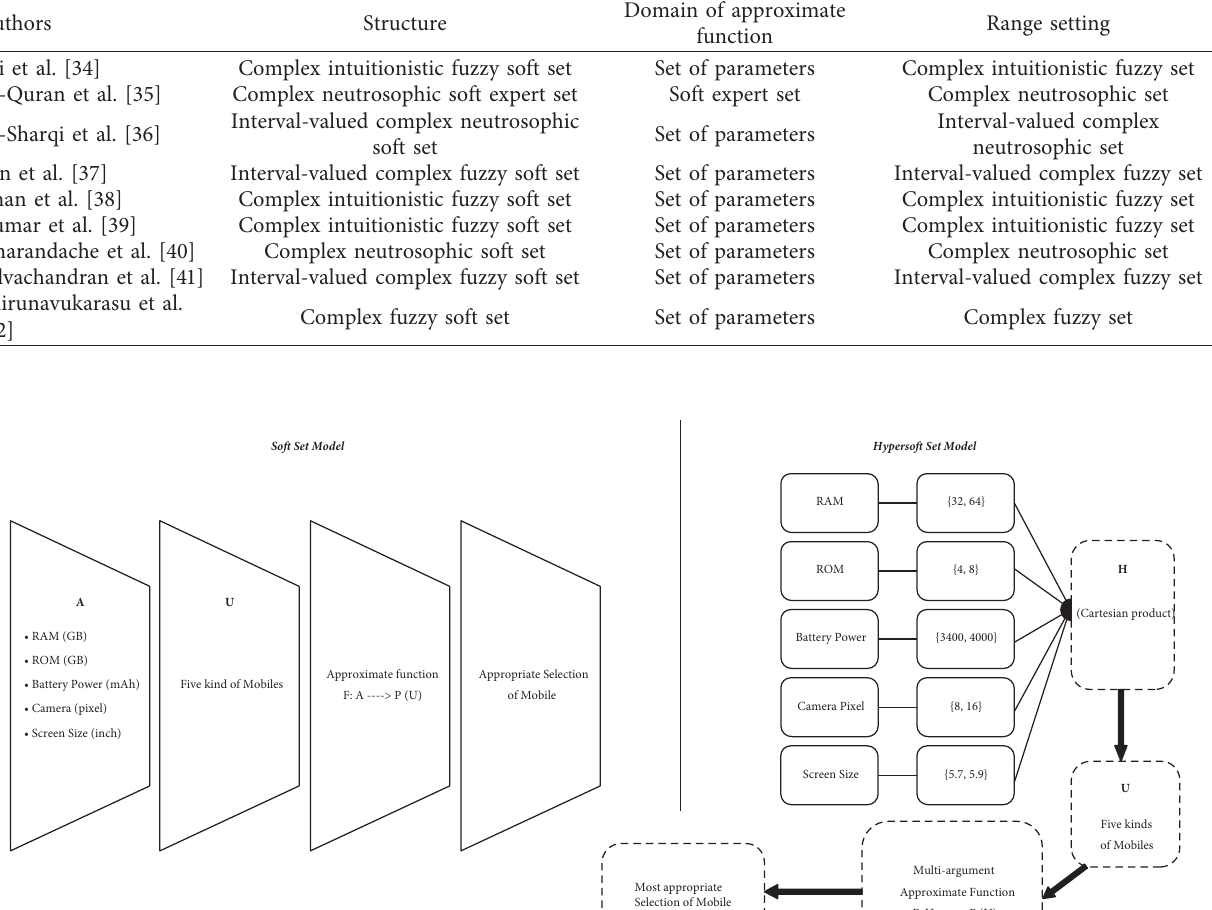
Table 1: Literature review on complex fuzzy-set-like models under soft set.